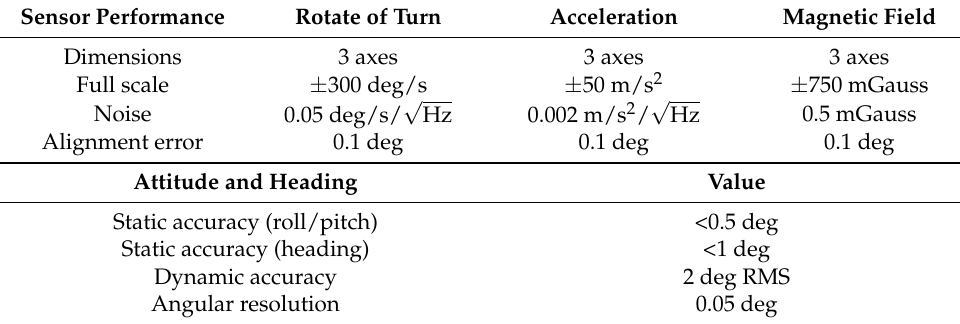
Table 1. Technical specifications of the XSENS MTi-28A53G35